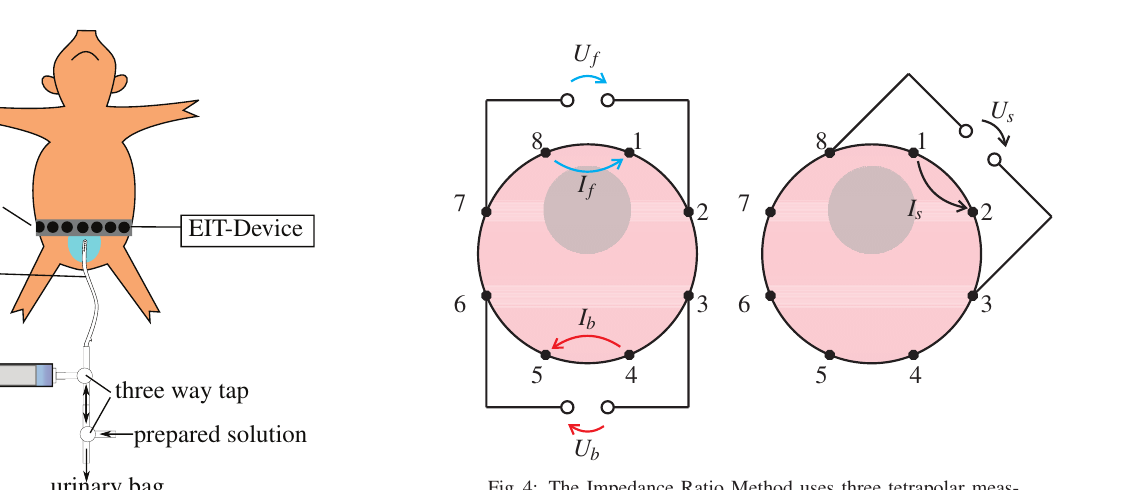
Fig.4: The Impedance Ratio Method uses three tetrapolar meas- urements at front (ventral, U f / I f ), side ( U s / I s ) and back (dorsal, U b / I b ) positions.